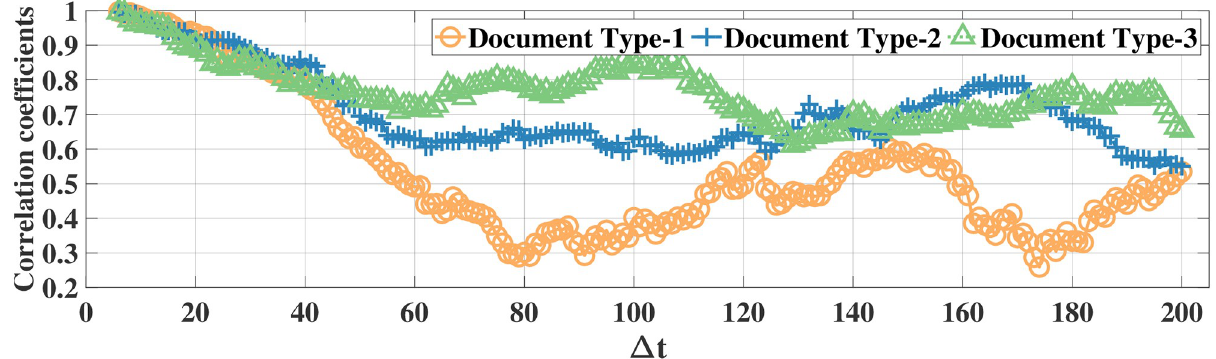
Fig 3. Correlation coefficients of the raw signals of feature ratio large saccade in the MPIIDPEye dataset. The values are calculated over a time difference of Δ t (Each time step corresponds to 0.5s) w.r.t. the samples at the fifth time instance.